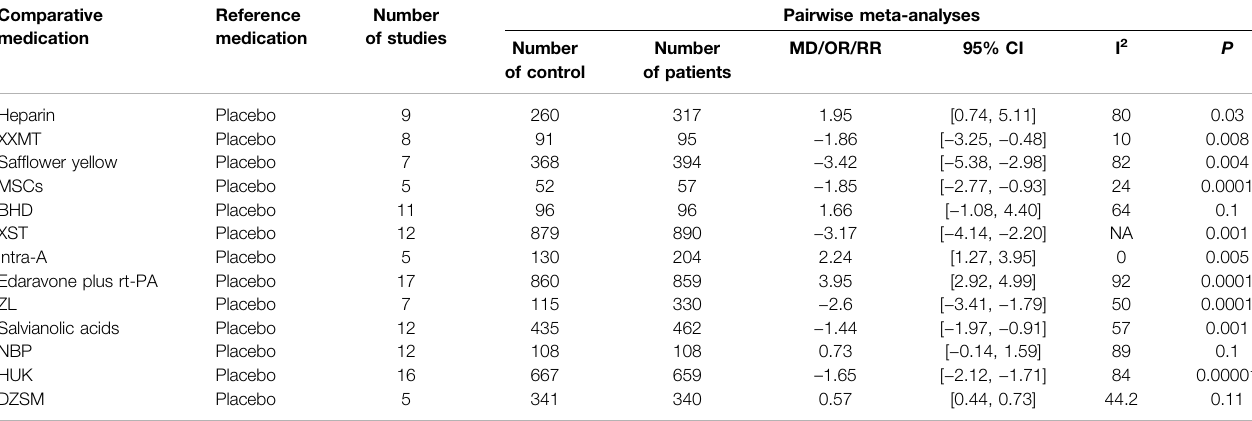
TABLE 3 | Results of pairwise meta-analyses for the NIHSS score. Comparative medication